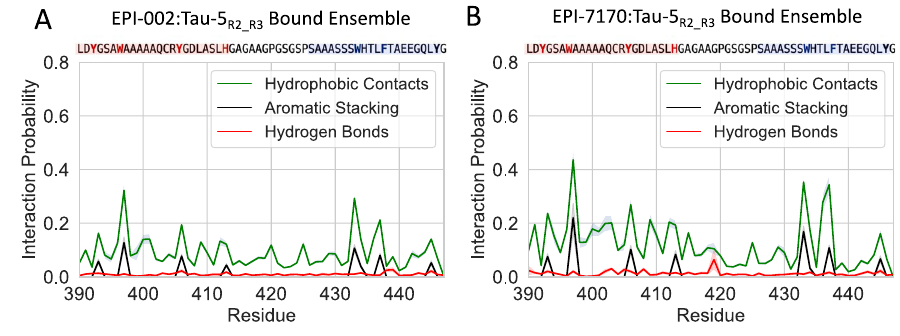
Fig. 4 | Protein-ligand intermolecular interactions in the Tau-5 R2_R3 :EPI-002 and Tau-5 R2_R3 :EPI-7170 bound ensembles. Populations of intermolecular inter- actions were observed in the Tau-5 R2_R3 :EPI-002 ( A ) and Tau-5 R2_R3 :EPI-7170 bound ensembles ( B ). Populations are calculated considering only the bound frames of